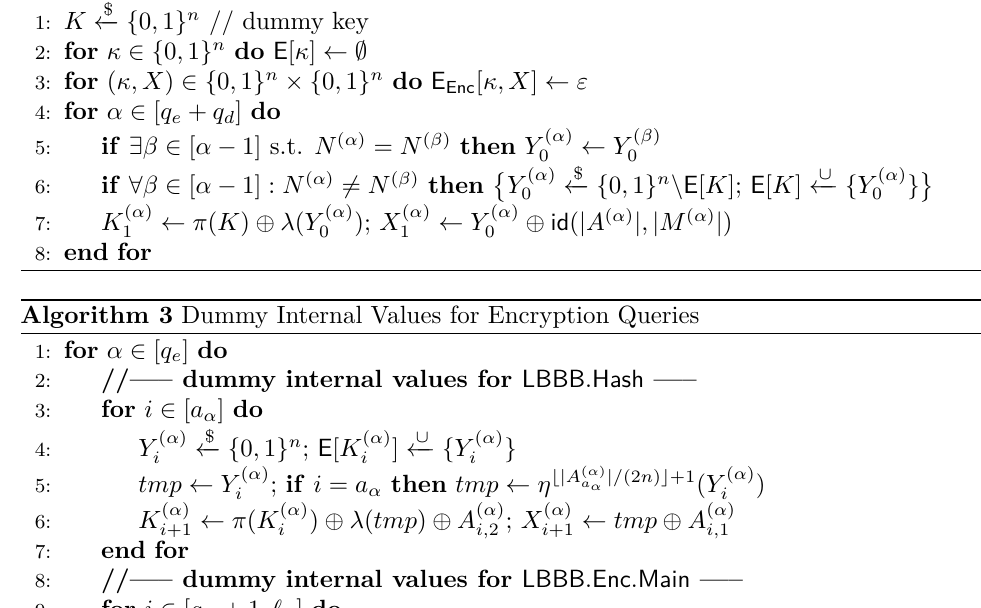
Algorithm 2 Dummy Internal Values for Initial Blocks